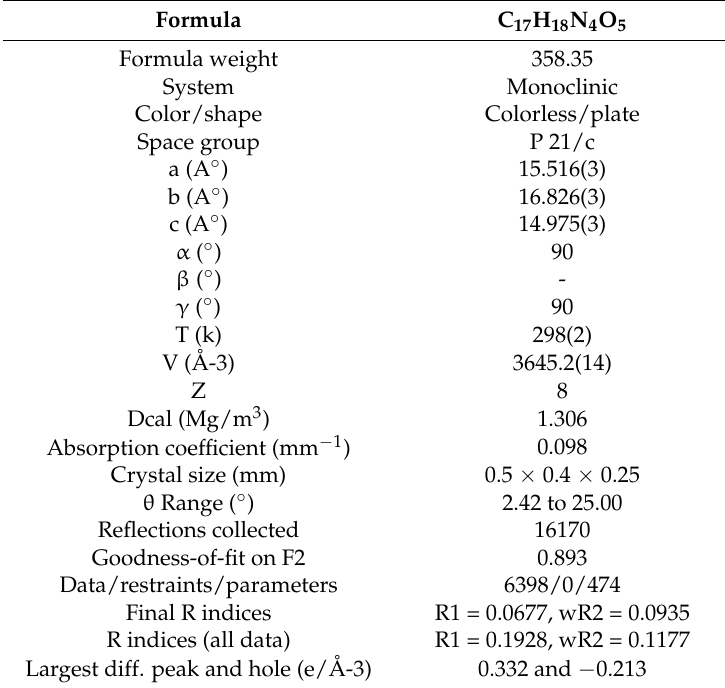
Table 6. Crystal structure data of ligand.